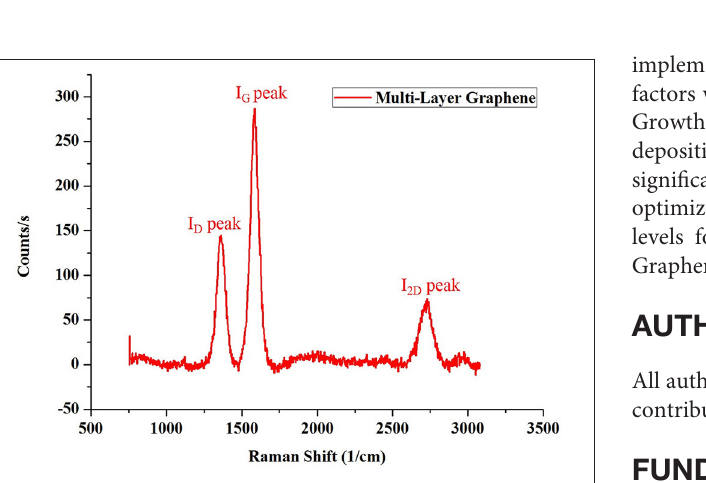
FIGURE 6 | Raman spectrum for the Ni sample treated with a recipe of 600 ◦ C temperature, 150W RF power, H 2 /CH 4 gas flux ratio of 50, 10min of deposition time and 10 sccm of Argon in PECVD chamber. Presence of I D , I G peaks, and a significant I 2D confirms presence of